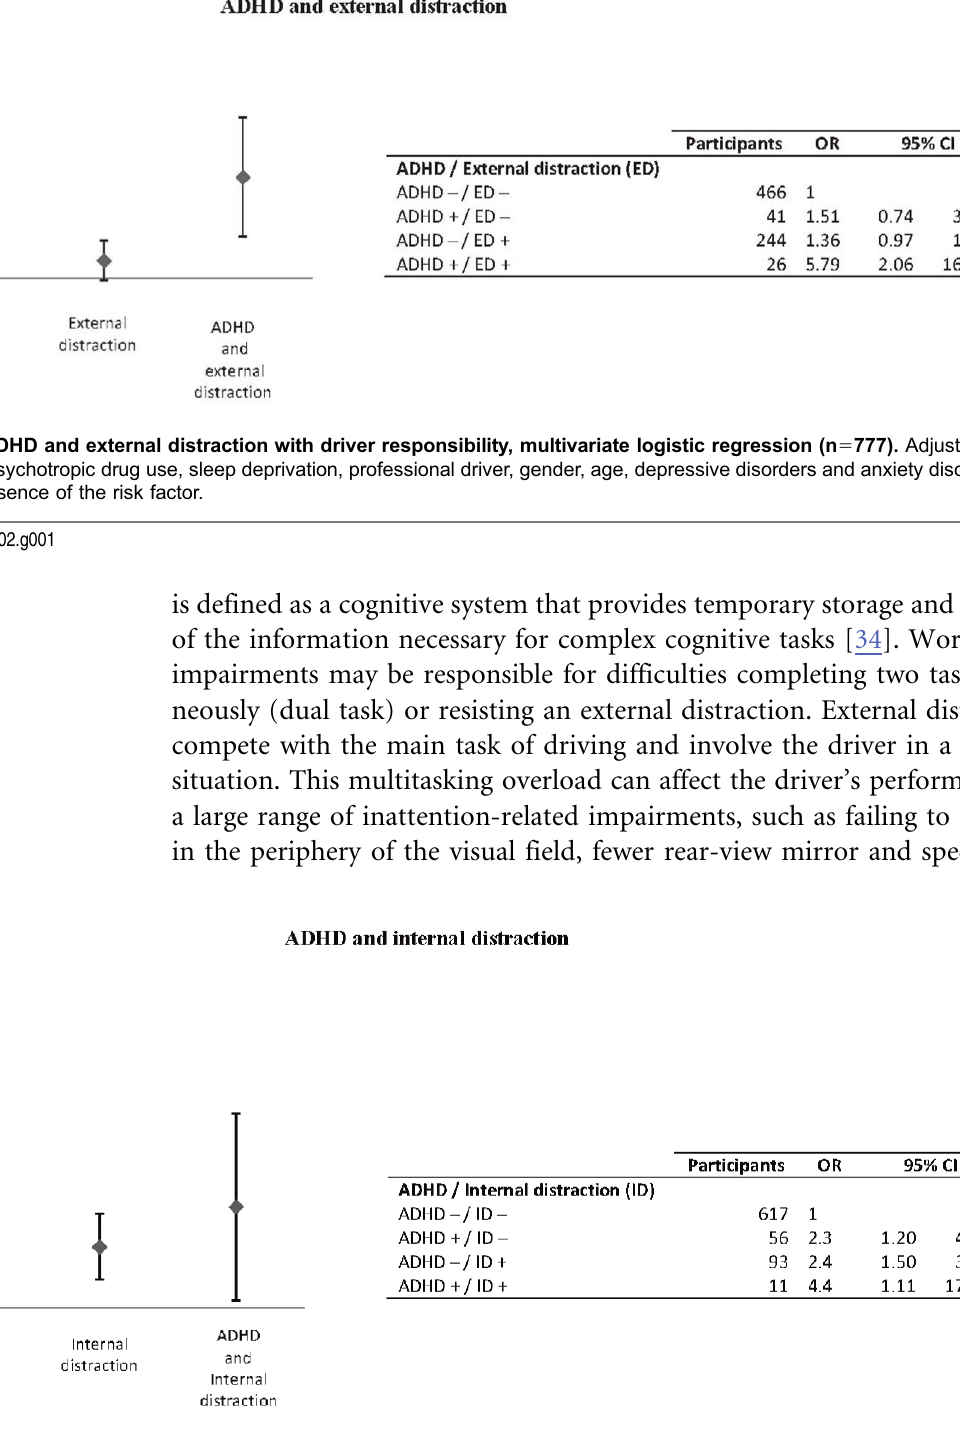
Fig. 2. Association of ADHD and internal distraction with driver responsibility, multivariate logistic regression (n 5 777). Adjusted for external distraction, alcohol use, psychotropic drug use, sleep deprivation, professional driver, gender, age, depressive disorders and anxiety disorders. ( + ) and ( 2 ) represent presence or absence of the risk